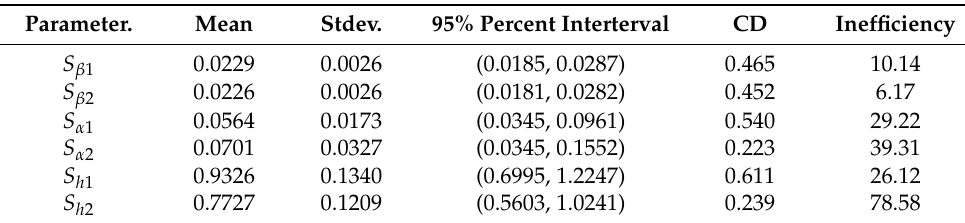
Table 2. Estimation results of selected parameters in the time-varying parameter autoregressive (TVP-VAR)